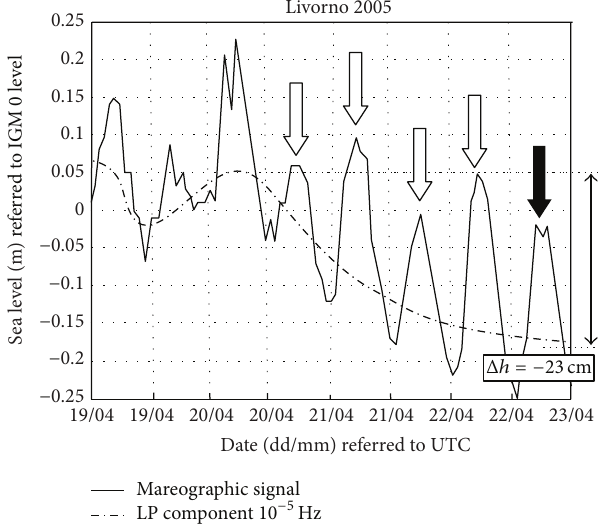
Figure13: Sea level variations inPortof Livorno(original signaland its low pass component in dotted line) (image from [15]).